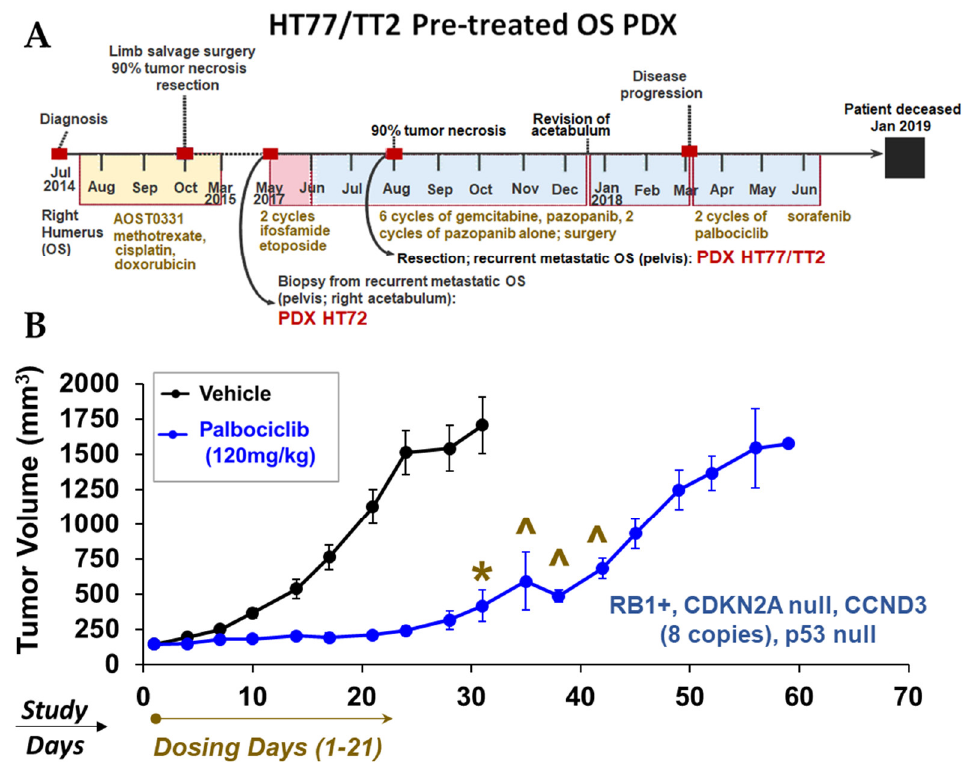
Figure 16. CDK4/6 inhibitor, palbociclib, significantly blocks growth of PDX HT77. ( A ) HT77 PDX was derived from a metastatic lesion of a pretreated 18-year-old male OS patient harboring molecular signatures indicative of CDK4/6 activation. ( B ) Mice were treated with vehicle ( n = 8) of palbociclib ( n = 7) at 120 mg/kg for 5 consecutive days PO, SID, daily for 3 weeks. All tumor volumes are represented as mean +/− standard error mean (SEM). Two-way ANOVA with Holm–Sidak multiple comparison test; * p < 0.05, ^ p < 0.0001. Note: For HT77, statistical analyses were conducted up to the point that all mice were still in the study (day 41).